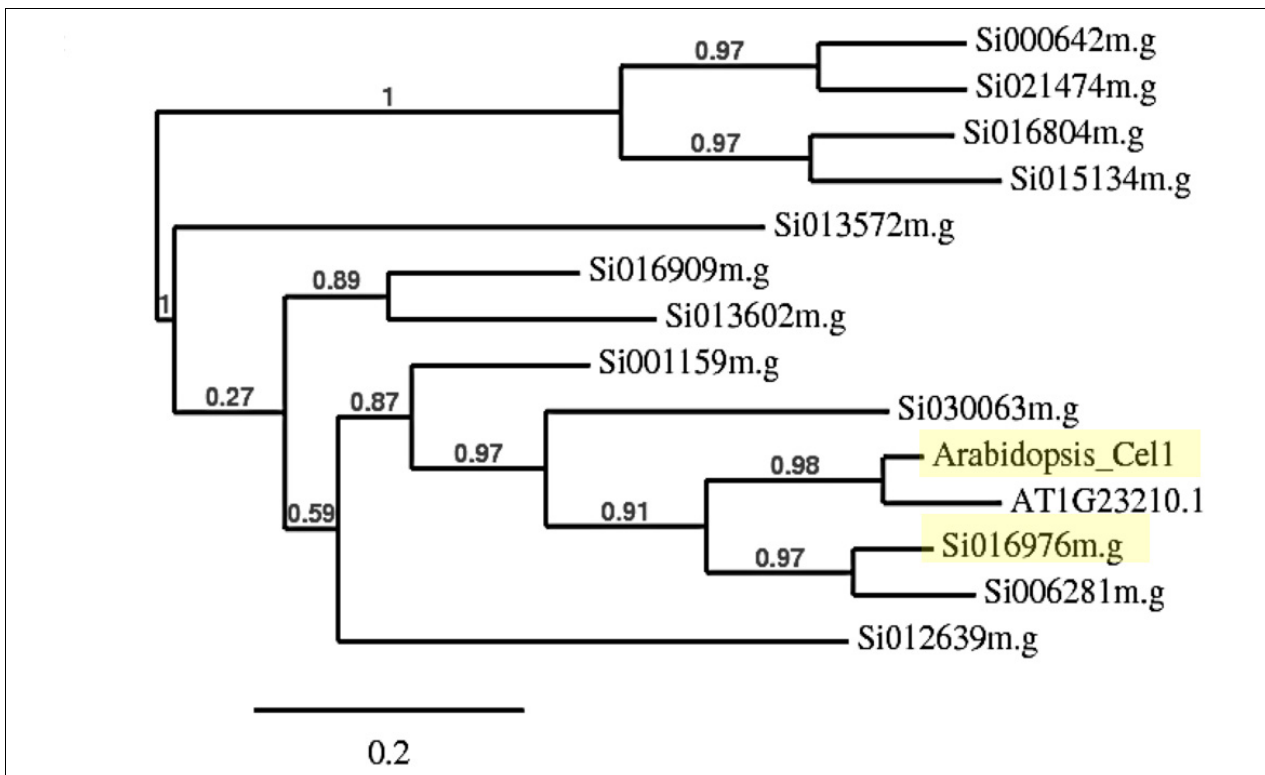
FIGURE 1 | Neighbor-joining phylogenetic tree of Atcel1 homologs in S. italica . The relative branch lengths indicate that Si016976m.g is more closely related to Atcel1 (both highlighted in yellow) and therefore referred to as Sicel1